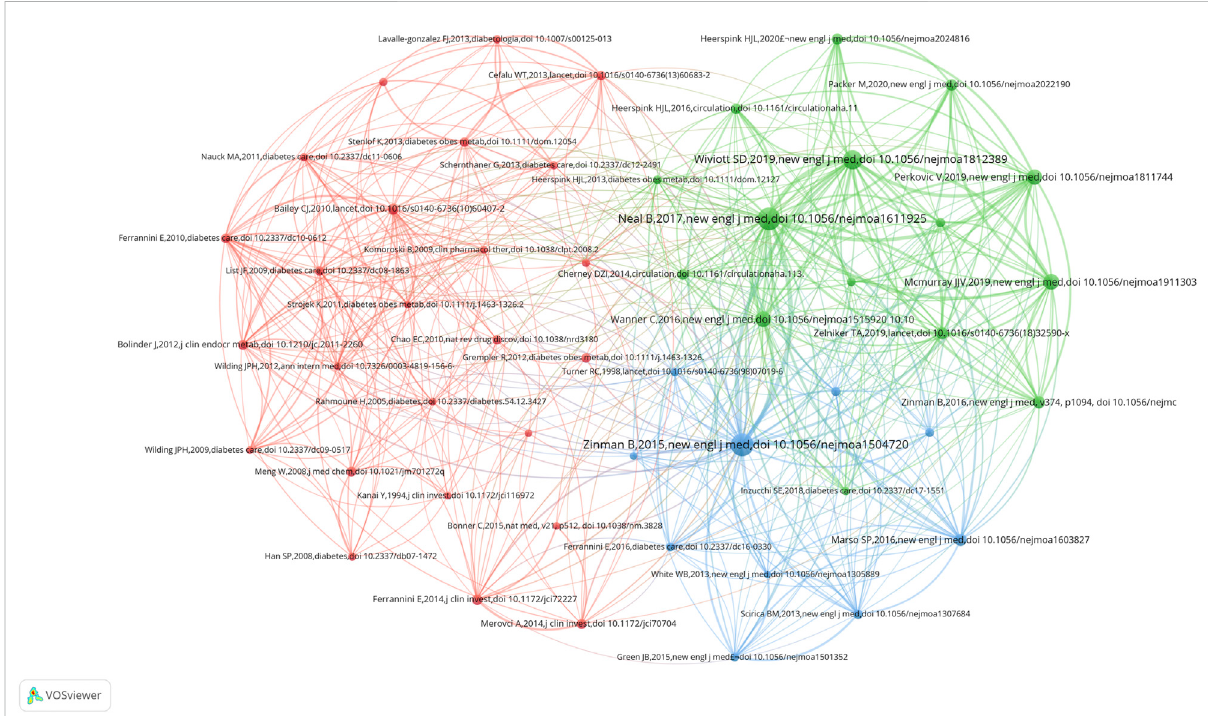
FIGURE 6 VOSviewer network visualization map of the top 50 cited references. Each node represents a reference, where the size of the node represents the citation counts, and each link between references indicates that the two references were co-cited, with a thicker line indicating a closer